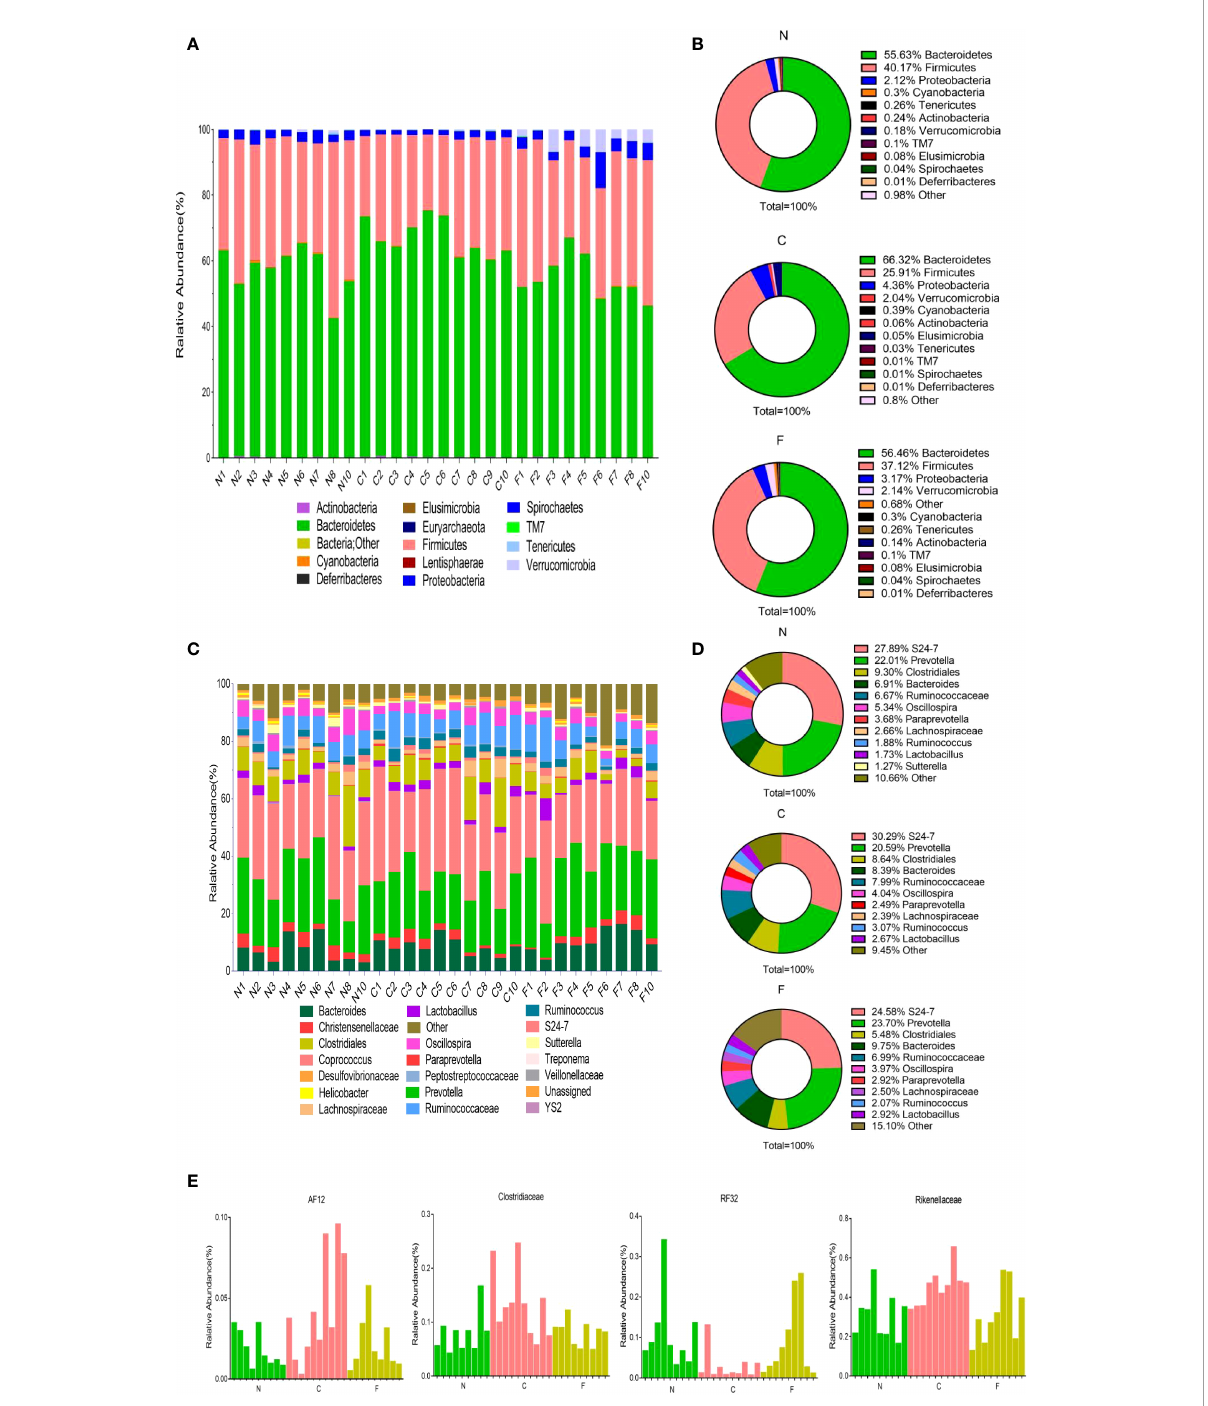
FIGURE 5 Results of 16s rDNA amplicon sequencing. (A) , Distribution of population composition by phylum rank; (B) , Pie chart of dominant populations by phylum rank; (C) , Distribution of population composition by genus rank; (D) , Pie chart of dominant populations by genus rank; (E) , Differences in selected populations of interest. N, Normal group; C, CUMS group; F, CUMS+ FMT